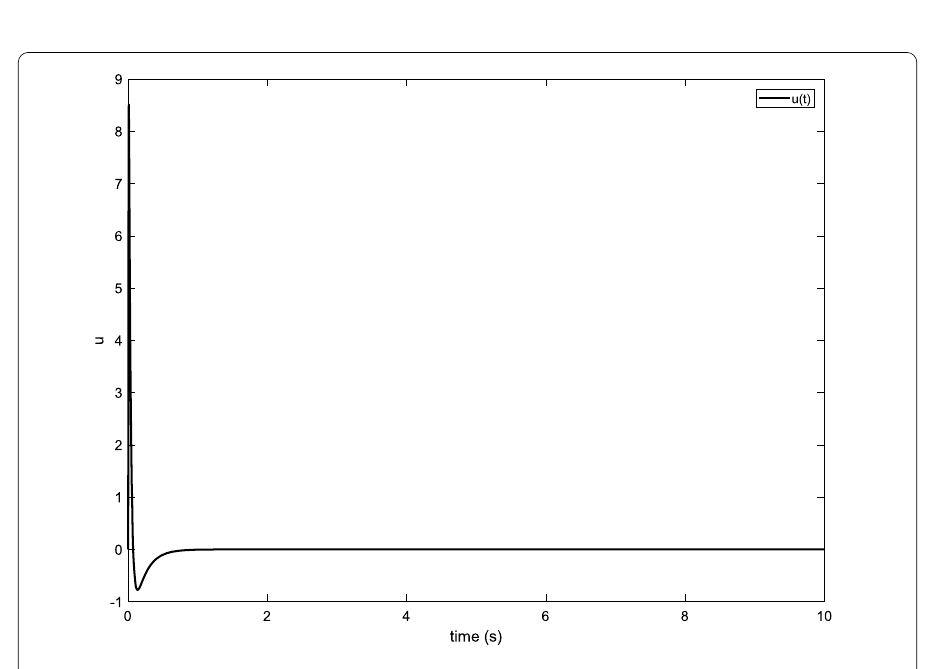
Figure 6 Time evolution of the control input (39) obtained by the proposed